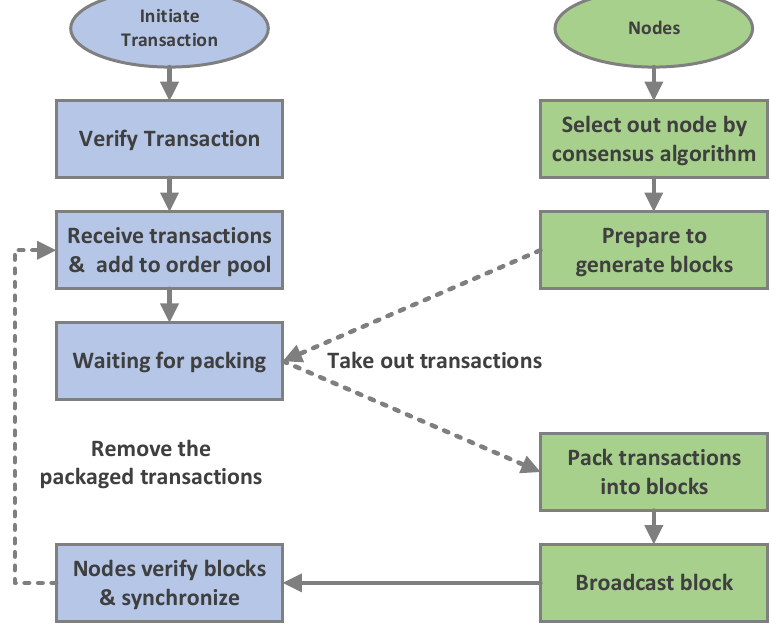
Figure 6. Flowchart of transactions from initiation to packaging to